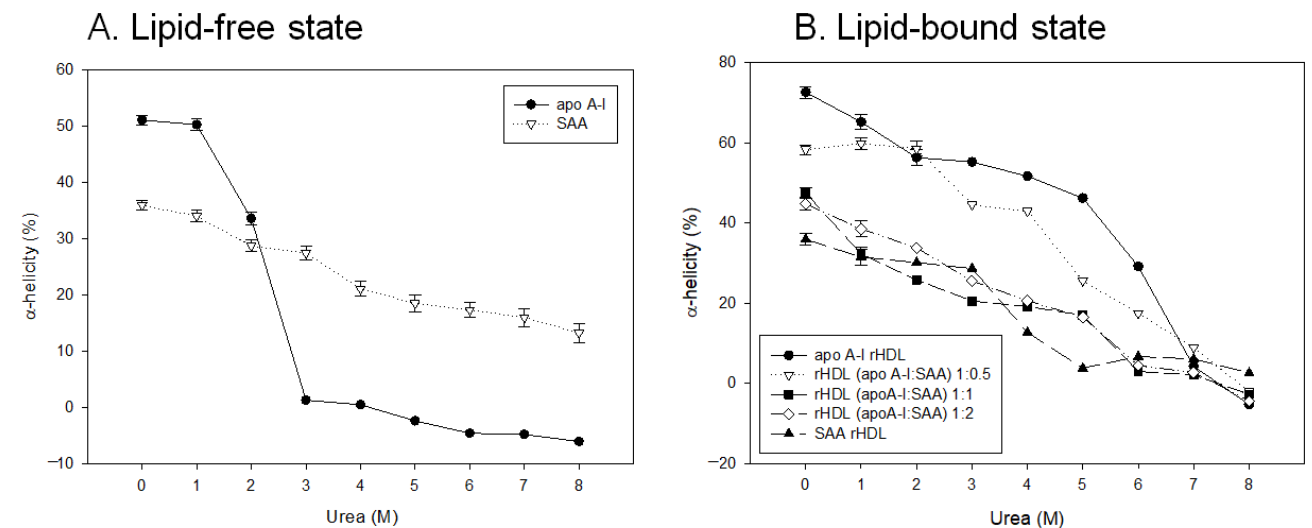
Figure 4. Isothermal denaturation of apoA-I and serum amyloid A (SAA) in the lipid-free state ( A ) and the lipid-bound state ( B ) as reconstituted high-density lipoproteins (rHDL) with different molar ratios of apoA-I:SAA. With increasing urea treatment, the change in α -helicity was compared by circular dichroism spectroscopy.